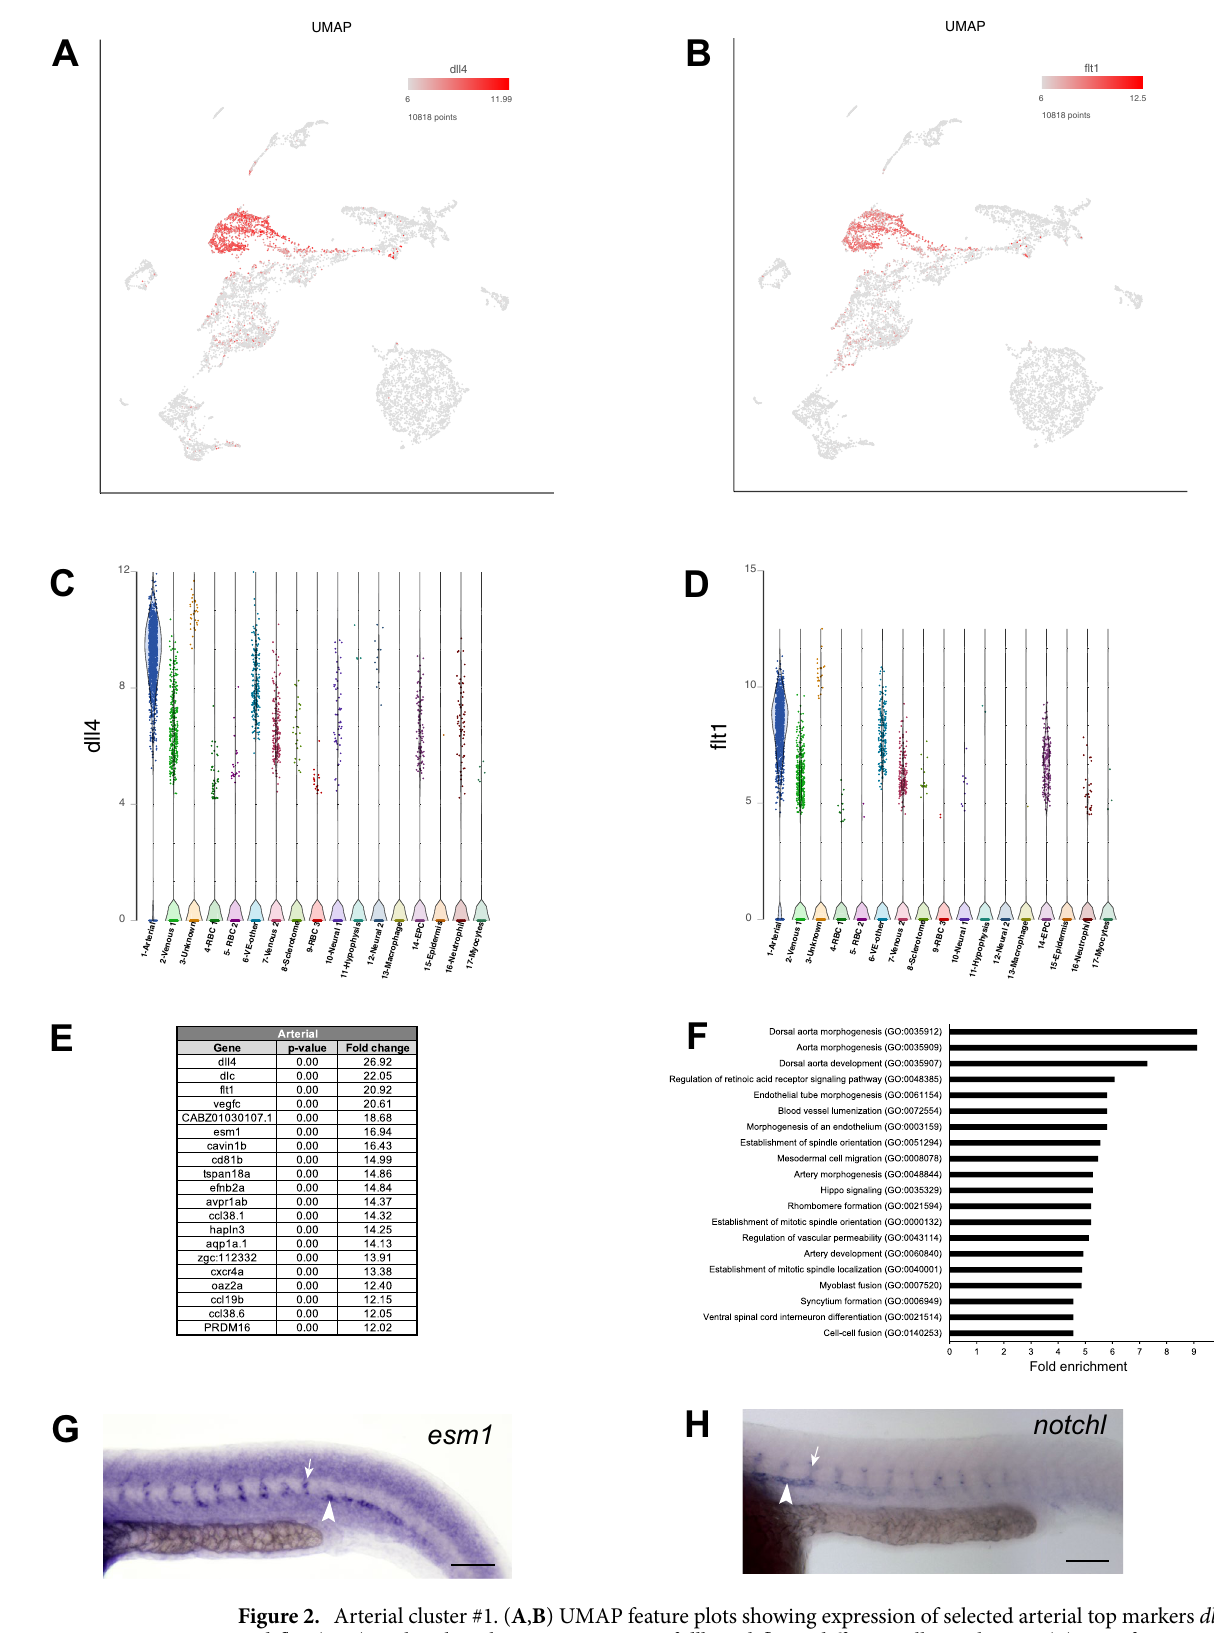
Figure 2. Arterial cluster #1. ( A , B ) UMAP feature plots showing expression of selected arterial top markers dll4 and flt1 . ( C , D ) Violin plots showing expression of dll4 and flt1 in different cell populations. ( E ) List of top 20 marker genes differentially expressed in arterial cluster. ( F ) List of top 20 pathways enriched in arterial cluster. ( G , H ) In situ hybridization analysis at 24 hpf for selected marker genes esm1 and notchl . Note the expression of esm1 and notchl in the dorsal aorta (arrowhead) as well as the intersegmental vessels (arrow). Scale bars: 100